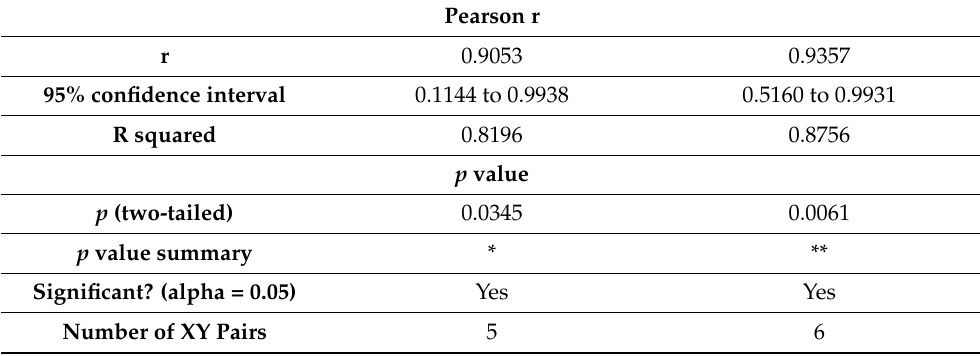
Table A4. Correlation using Pearson’s correlation coefficient analysis between polymer